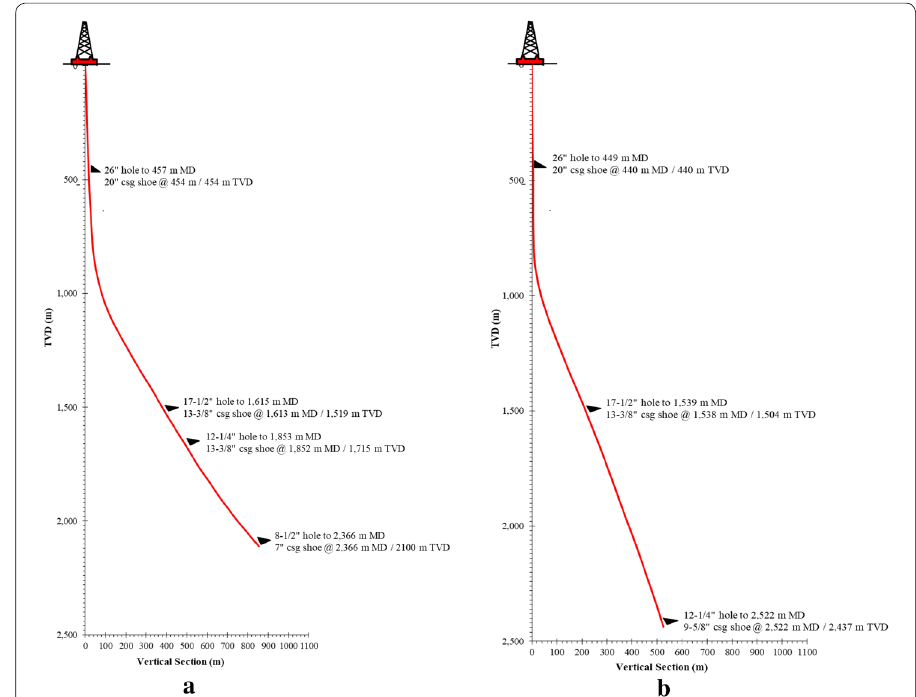
Fig. 2 Well trajectory of a HCE9B and b HCE28B (Marbun 2013; PT Geo Dipa Energi 2019)